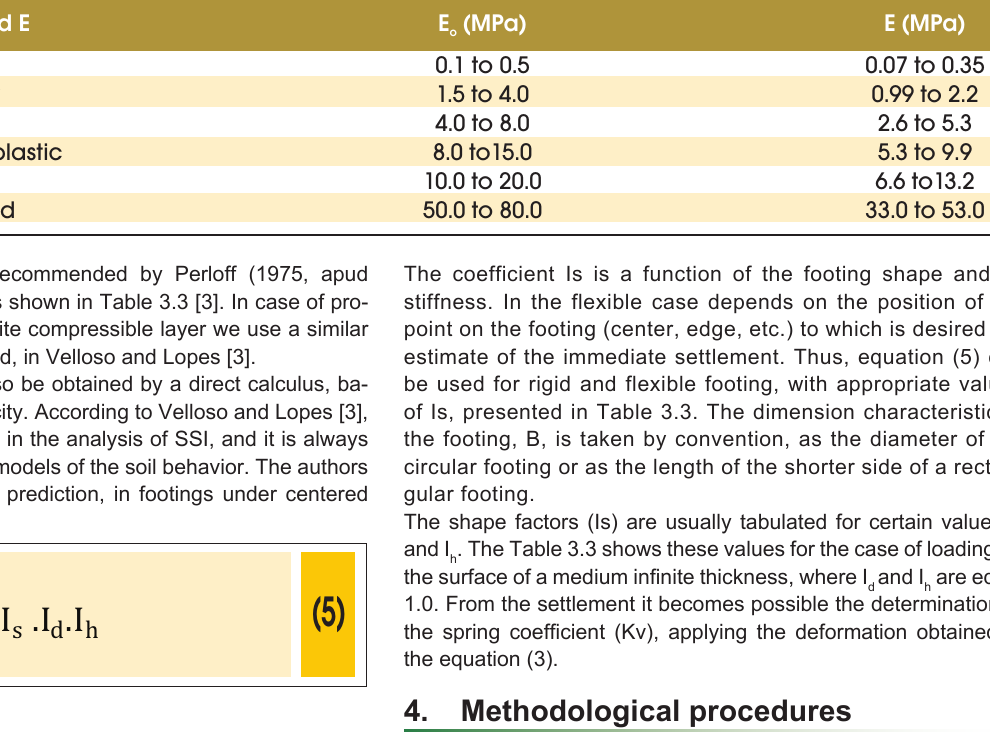
Table 3.2 – Values of E (endometrial elasticity module ) and E (elasticity module) o Values of E and E o